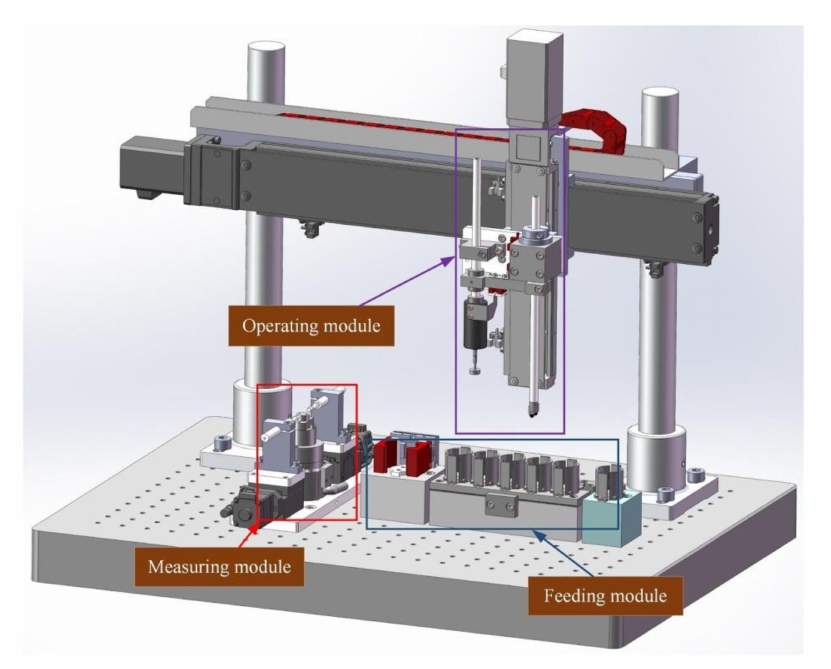
Figure 3. The overall design scheme of this